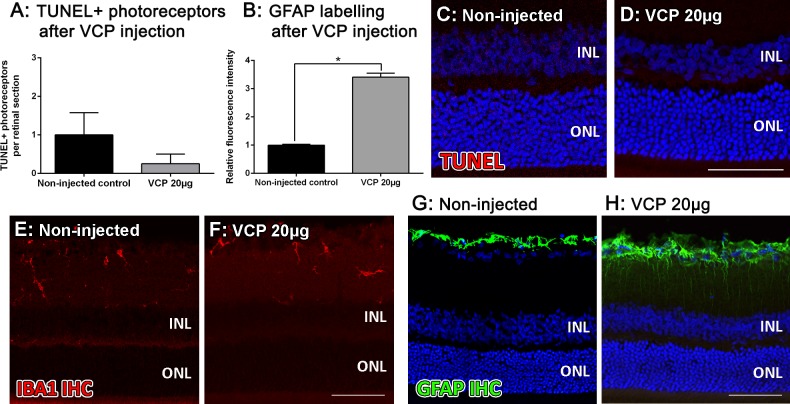
Effect of an intravitreal injection of 20μg VCP on cell death, inflammation and retinal stress at 7 days.A: There was no significant difference in the number of TUNEL+ photoreceptors between VCP-injected and non-injected retinas (P>0.05). B: A significant increase in GFAP labelling was detected after the VCP injection compared to non-injected controls (P<0.05) C-D: No TUNEL+ cells were observed in the inner retina, and only 0–1 TUNEL+ photoreceptors per retinal section were identified in both VCP-injected and non-injected groups. No difference in retinal morphology was observed between these groups. E-F: IBA1+ cells remained in the inner retina and displayed a ramified morphology. No IBA1+ cells were detected in the outer retina of either group. G-H: Low levels of GFAP immunostaining was observed near the GCL, indicating Müller cell and astrocyte labelling in the non-injected control (G), however an increase in GFAP was detected in the VCP-injected retina (H). INL, inner nuclear layer; ONL, outer nuclear layer. Statistical analysis was performed using a Student’s t-test. Scale bars indicate 50μm and error bars are displayed as SEM. N = 3 for all experimental groups.